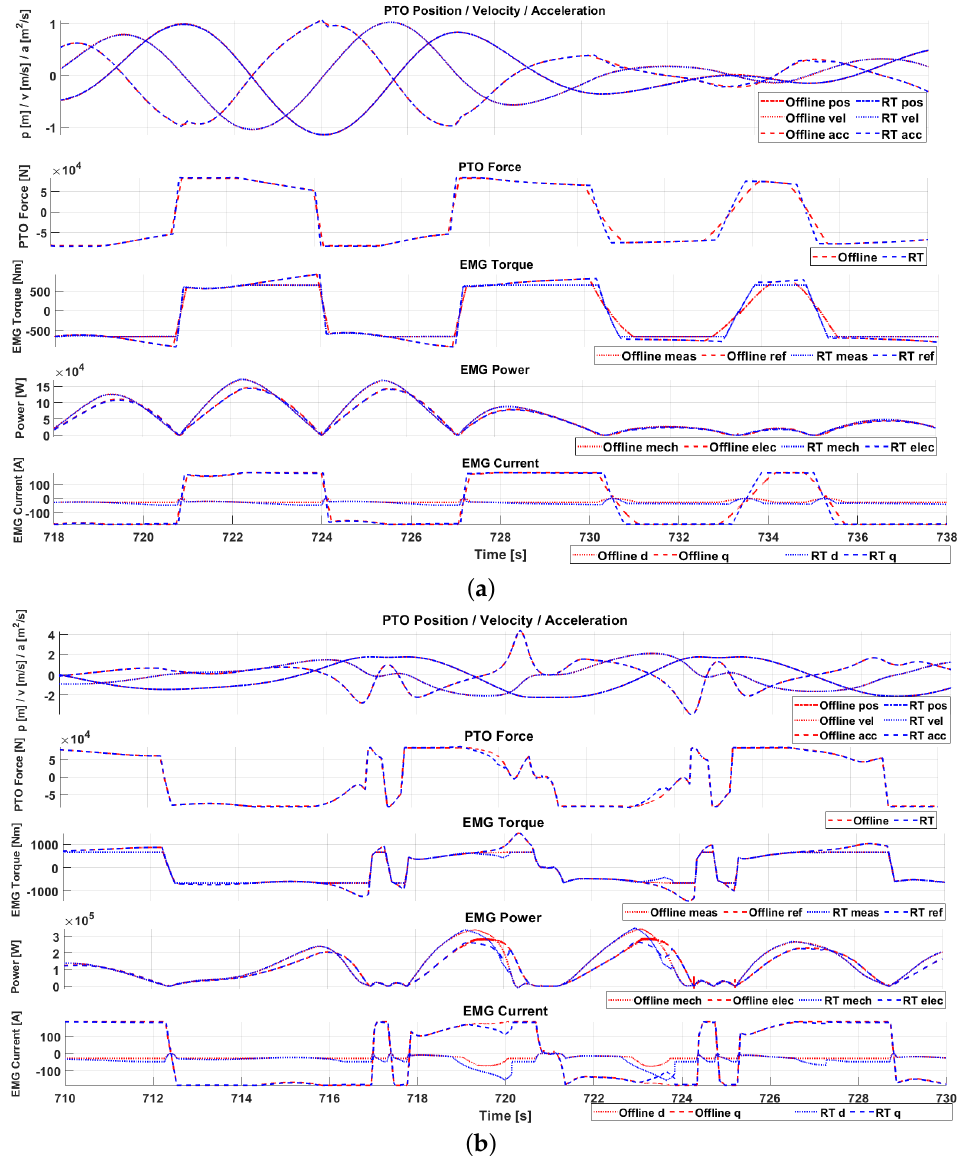
Figure 7. Visual comparison between offline and real − time models for two sea states: ( a ) T p = 7s, H s = 2.25m; ( b ) T p = 8s, H s =